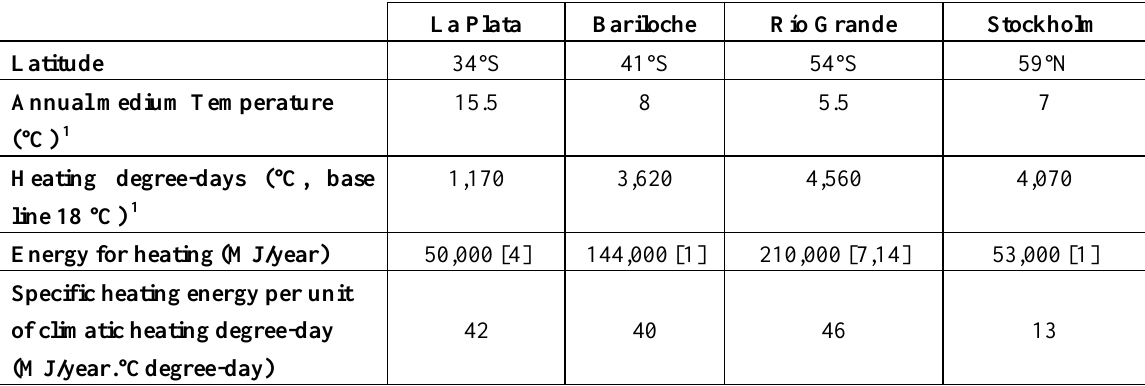
Table 3. Energy use for heating in locations in Argentina and